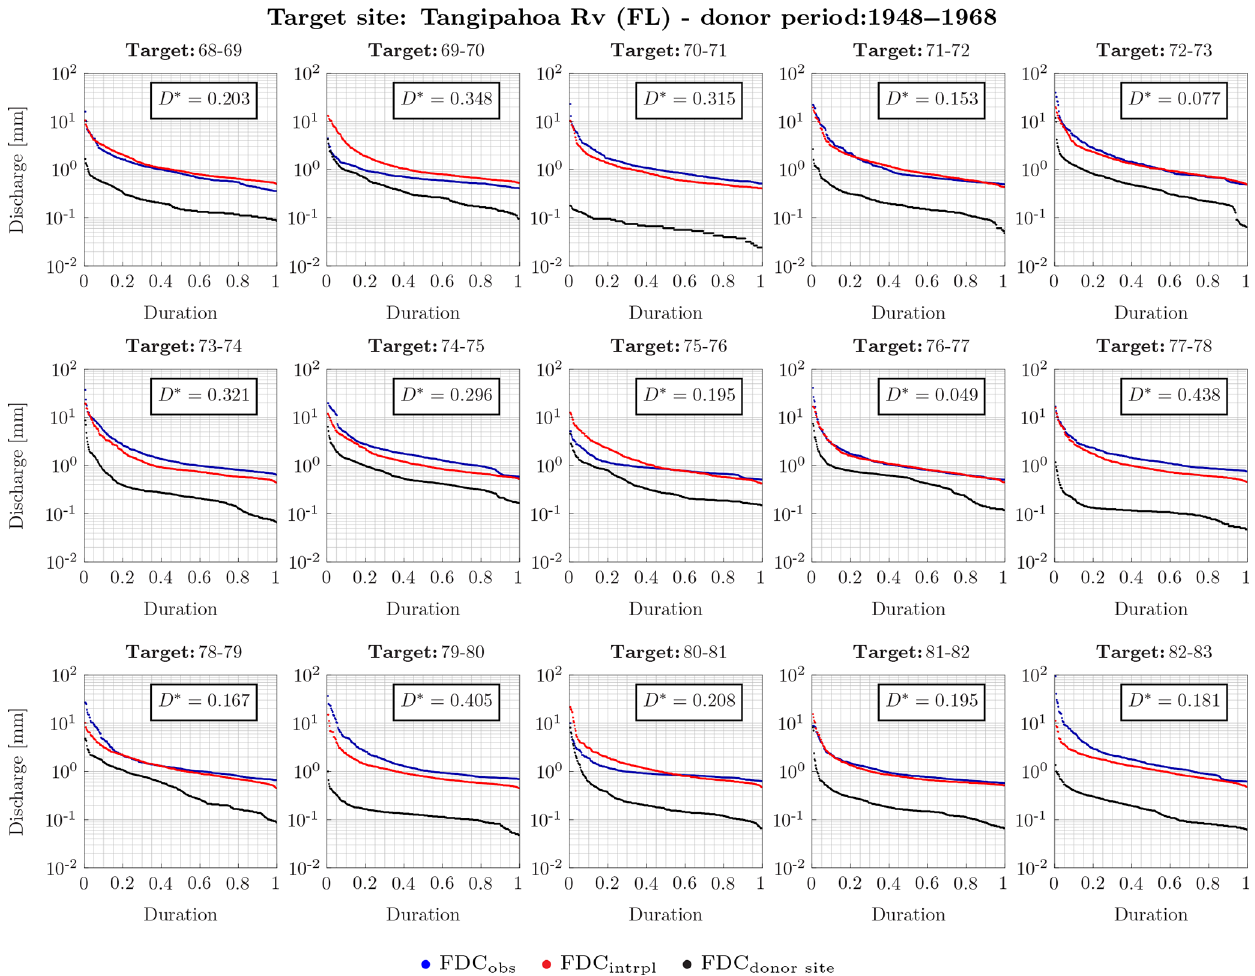
Figure 9. Interpolated FDC at Tangipahoa River (FL). The donor basin is Blanco River (TX). The donor years are a 20-year time window from October 1948 to September 1968. Target years are each hydrological year from October 1968 to September 1983. The blue and red dots are observed and interpolated FDC, respectively, at the target basin during the target period; the black dots are the observed FDC at the donor basin during the target period. In each box the Kolmogorov–Smirnov distance, D ∗ , is reported. The p value of the test is always around zero, but for hydrologic years 1972–1973 and